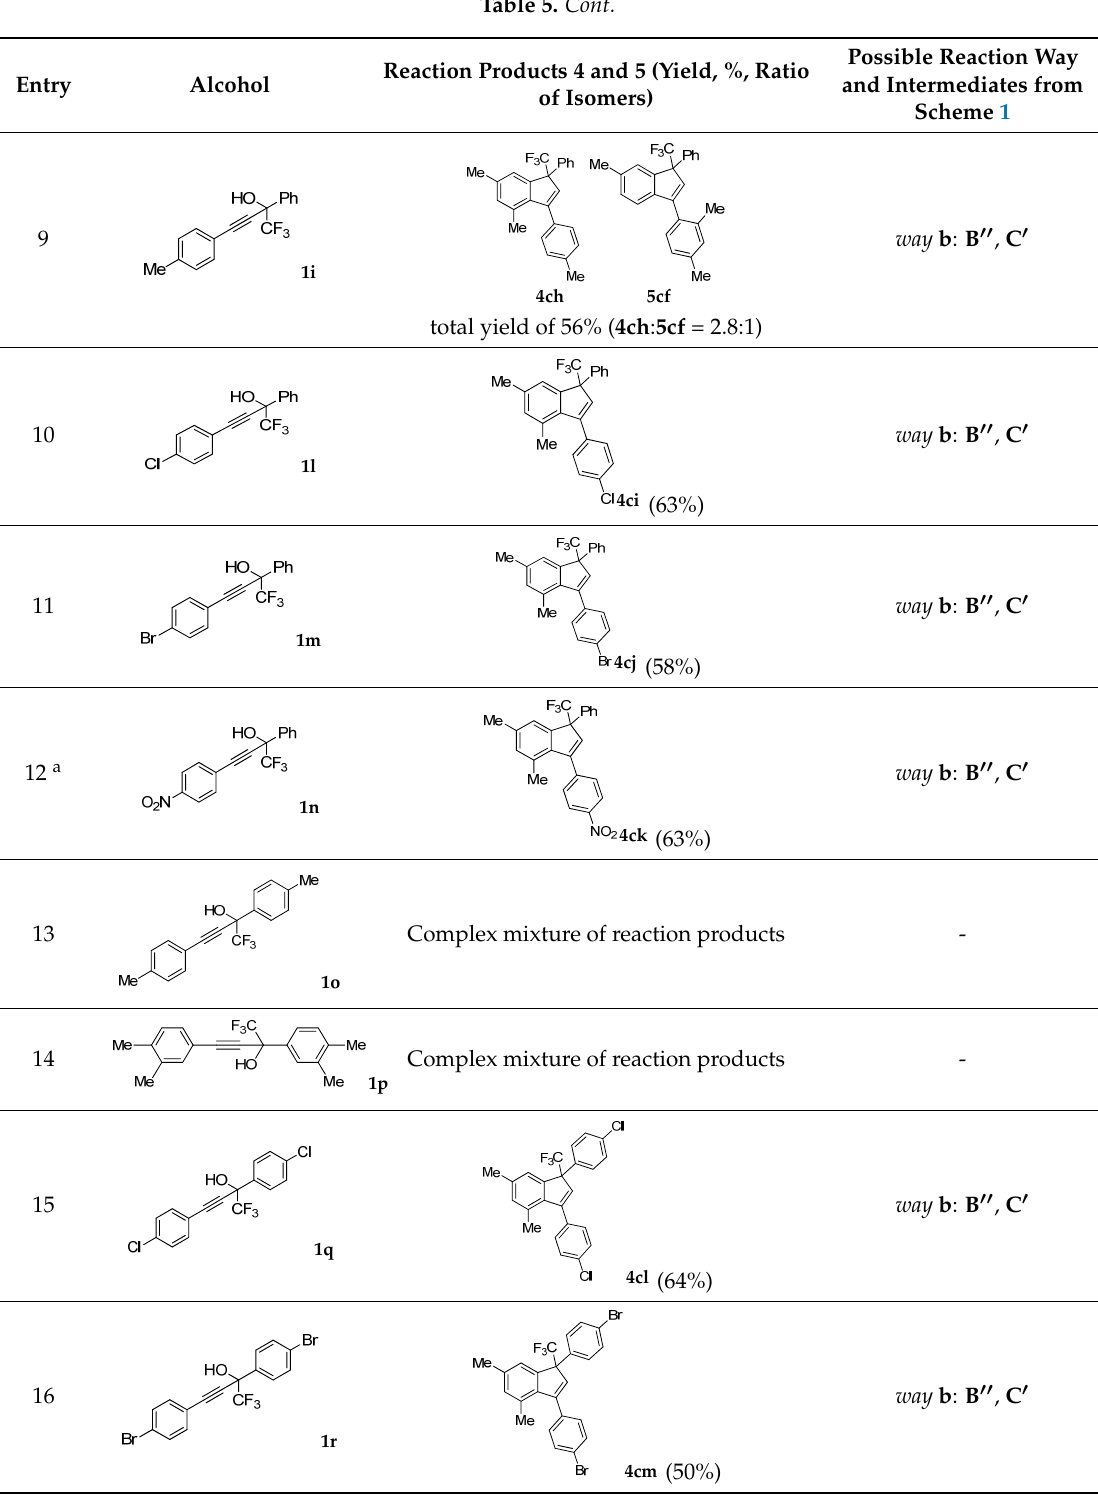
Complex mixture of reaction products